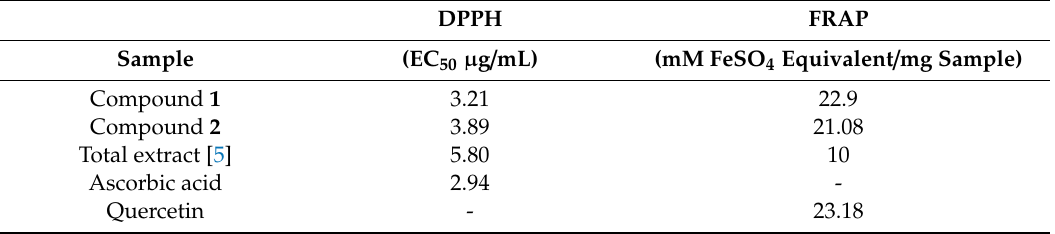
Table 2. Antioxidant activities of myricetin-3- O - α -rhamnoside (compound 1 ) and 3,5-di- O -methyl gossypetin (compound 2 ). The EC 50 values for total extract, ascorbic acid and quercetin are reported for